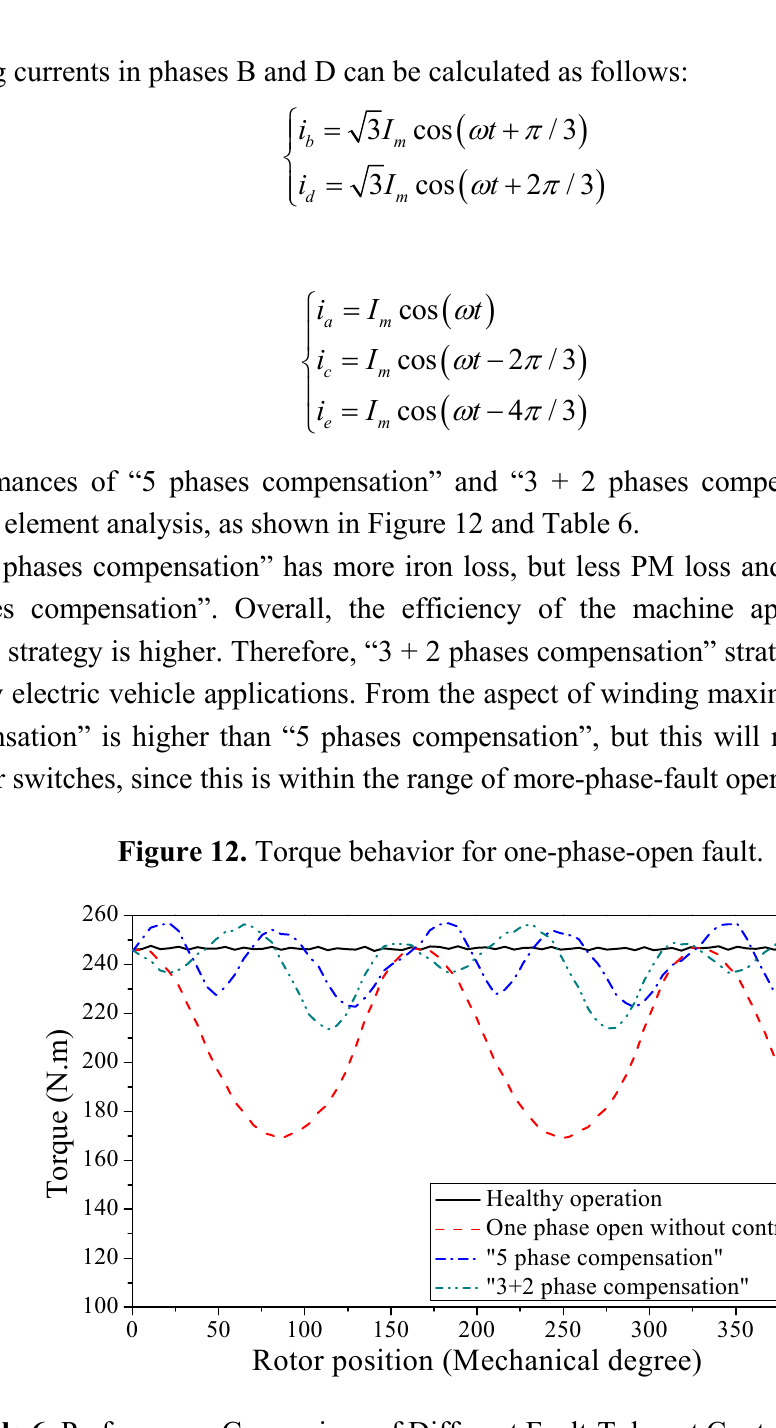
Table 6. Performance Comparison of Different Fault-Tolerant Control